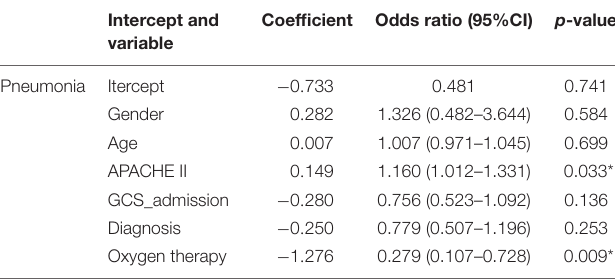
TABLE 4 | Logistics regression analysis of pneumonia occurred during hospitalization.